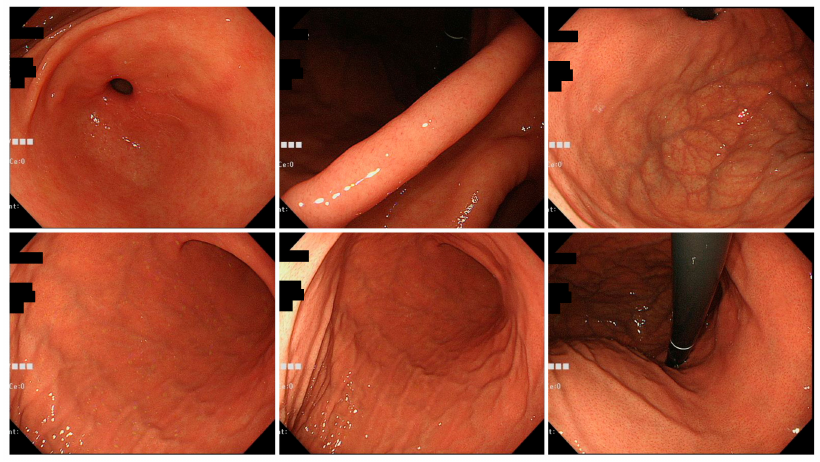
Figure 4. Typical endoscopic images of H. pylori -infected gastric mucosa in the Okinawa group. This patient is a 46-year-old woman. C-1 atrophy is observed, and there are few findings of H. pylori infection. Closed-type atrophy was more common in the Okinawa group than in the Tokyo group [318/435 (73.1%) vs. 131/352 (37.2%)] ( p < 0.001). Diffuse redness, mucosal swelling, enlarged fold, spotty redness, and sticky mucus are the findings of H. pylori- infected gastric mucosa. The following characteristics were significantly more common in the Tokyo group than in the Okinawa group: enlarged fold [114/352 (32.4%) vs. 113/435 (26.0%), p = 0.048], sticky mucus [125/352 (35.5%) vs. 73/435 (16.8%), p < 0.001], foveolar-hyperplastic polyp [50/352 (14.2%) vs. 39/435 (8.97%), p = 0.021], intestinal metaplasia [147/352 (41.8%) vs. 142/435 (32.6%), p = 0.007], and xanthoma [33/352 (9.38%) vs. 20/435 (4.60%), p < 0.001]. the Okinawa group: spotty redness [239/352 (67.9%) vs. 338/435 (77.7%), p = 0.002], patchy redness [29/352 (8.24%) vs. 59/435 (13.6%), p = 0.018], and hematin [6/352 (1.70%) vs. 28/435 (6.44%), p = 0.001] (Table 3). Table 3. Comparison of endoscopic findings according to the Kyoto Classification of Gastritis between the Tokyo and Okinawa